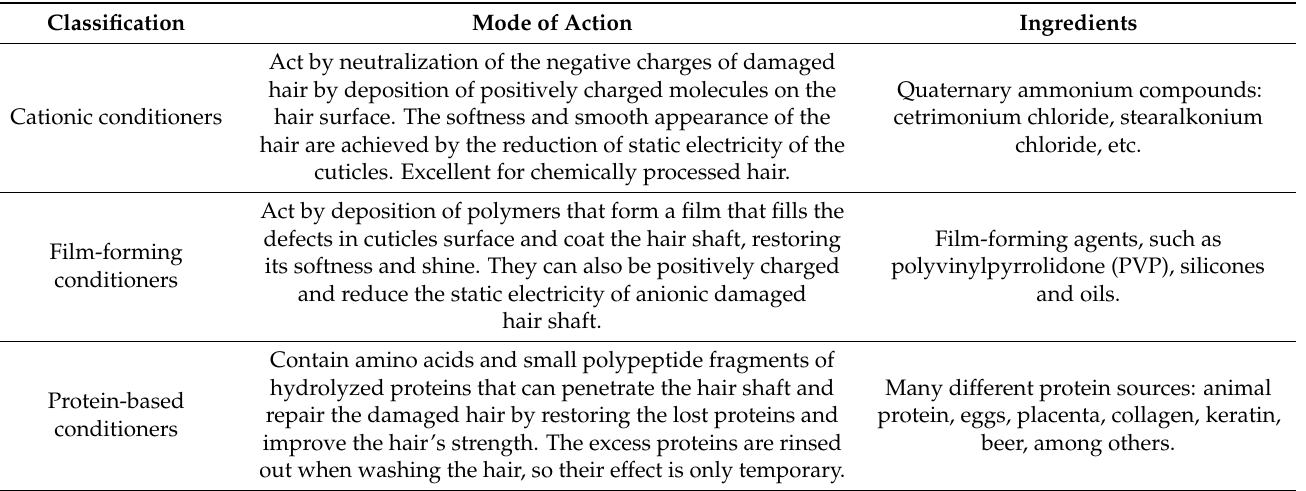
Table 2. Classification of hair conditioners based on their